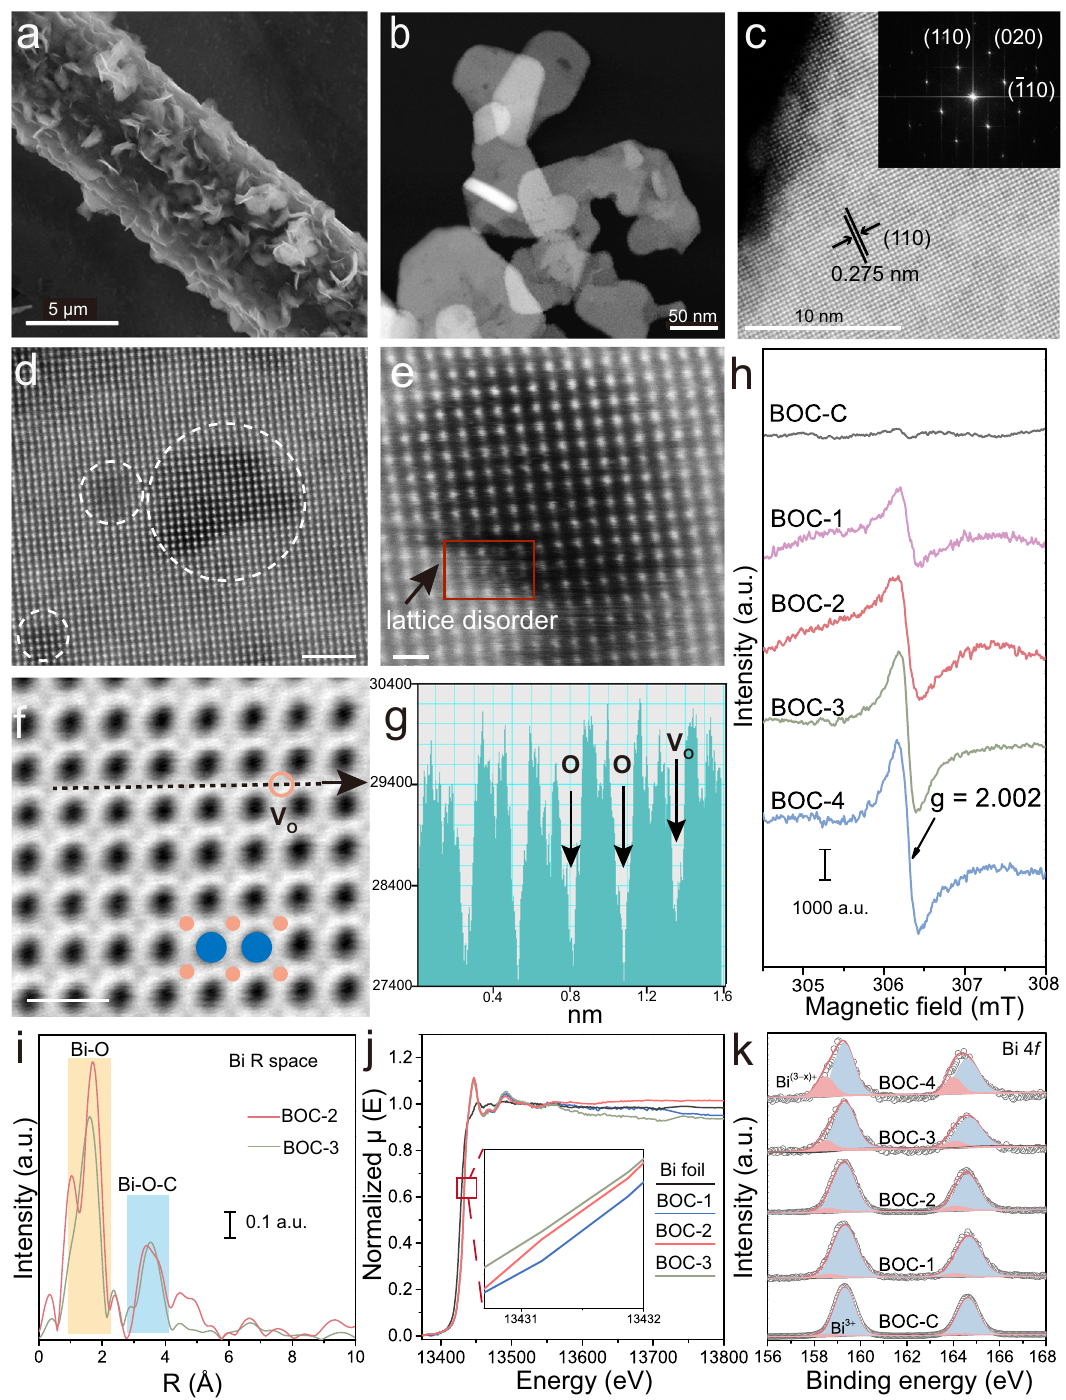
Fig. 1 | Characterizations of BOC and oxygen vacancy. a SEM, ( b ) TEM and ( c ) HRTEM images of BOC-2. d , e Atomic-resolution HAADF-STEM images of BOC-2, where the circled areas show the lattice disorders. The scale bar is 2nm in ( d ) and 0.5nm in ( e ), respectively. f ABF-STEM image of BOC-2, where the pink and blue circles represent oxygen and bismuth atoms, respectively. The scale bar is 0.5nm. g Intensity pro fi le corresponding to the black dashed line in ( f ), as directed by the